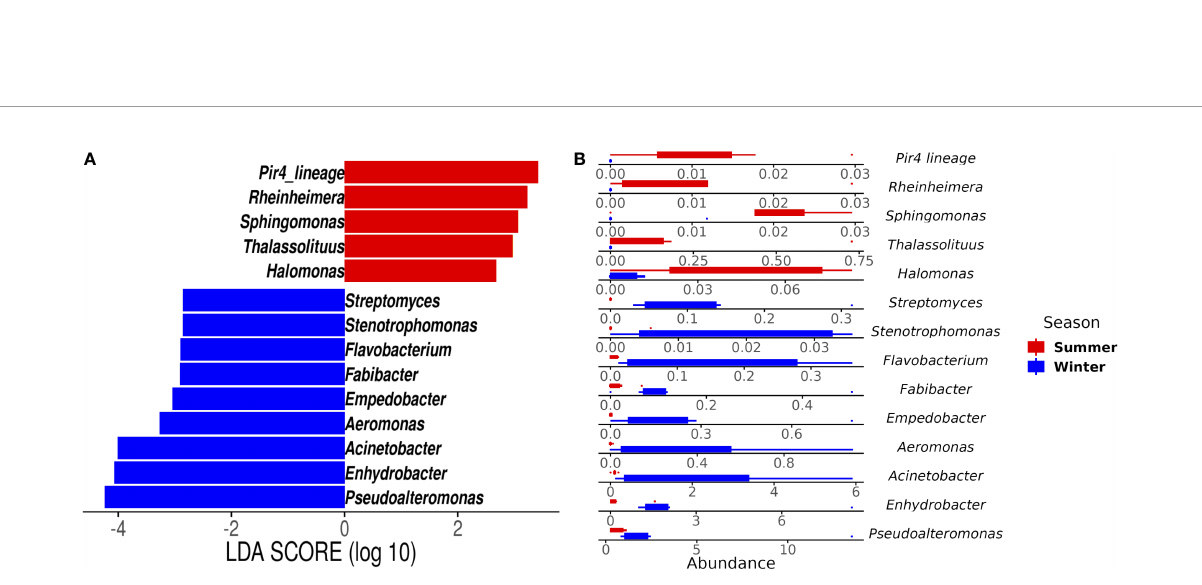
FIGURE 5 | Linear Discriminant Analysis of Effect Size (LEfSe) at the genus level by symbiotic condition in bleached medusas. The analysis shows (A) signi fi cant differences in dominant bacterial genera in Bleached medusas between day-0 (beige bars) and day-28 (gray bars) (LDA score>2, p <0.05). Horizontal columns represent the relative abundance of bacteria that were signi fi cantly different between symbiotic conditions. (B) Abundance for the genera highlighted by the LEfSe analysis for both sampling times. Note the different values for the x-axis.